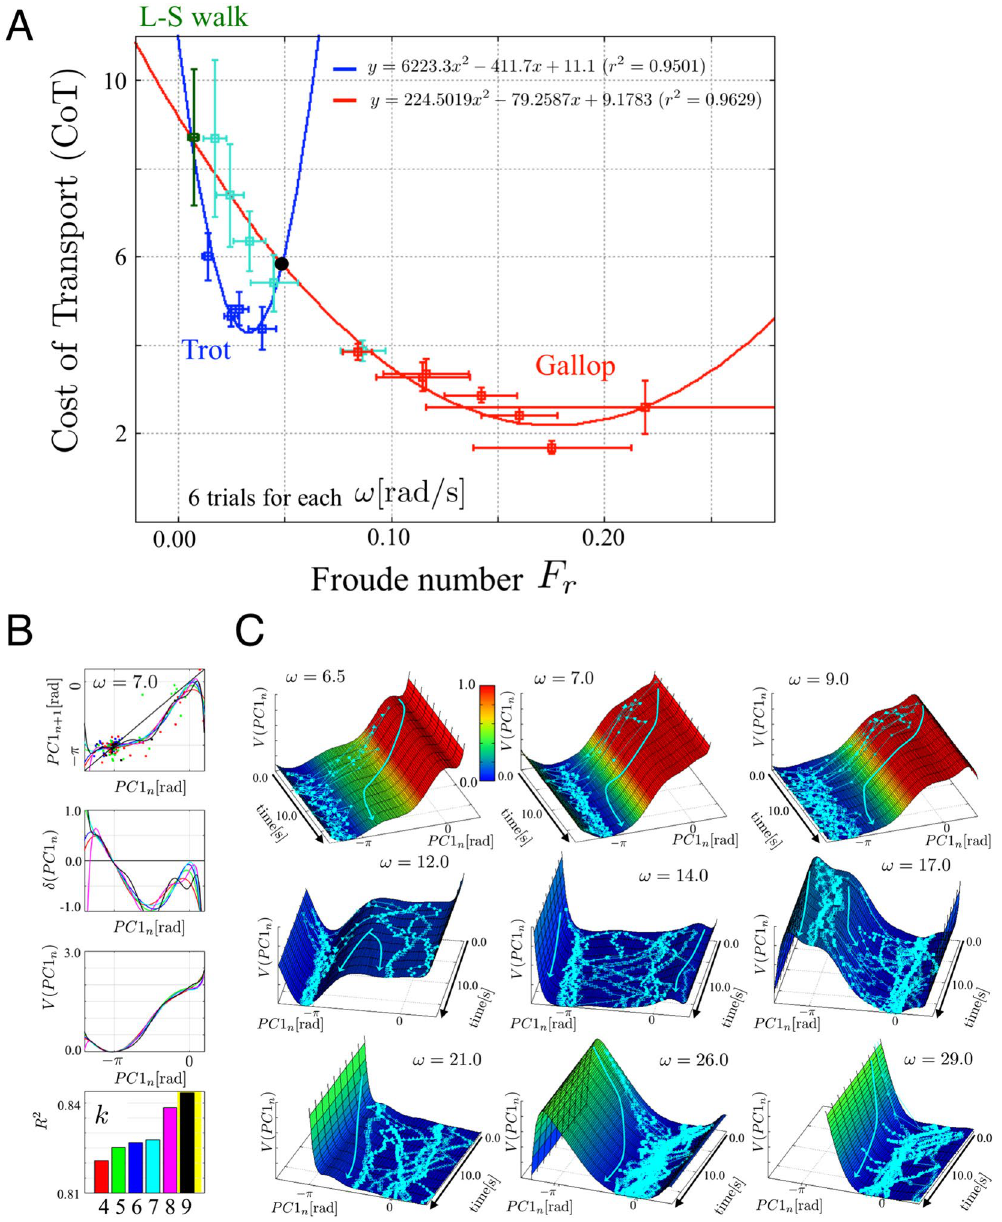
Figure 3. Efficiency and stability. ( A ) Cost of transport (CoT) versus Froude number F r for each value of ω . The colours of data points represent the range of ω values: dark green represents a value less than 6.5, blue represents values ranging from 7.0 to 9.0, cyan represents values between 12.0, and 19.0, and red represents values between 21.0 and 29.0. The blue and red lines represent the best-fitting second-order polynomial curves according to least-squares regression analysis for ω < 10 (blue) and ω > 10 (red). ( B ) The graphs from the top represent return maps PC 1 n + 1 = f ( PC 1 n ), δ PC 1 ( PC 1 n ), potential functions V PC 1 ( PC 1 n ), and R 2 values obtained using polynomial models for approximation for ω = 7.0 rad/s. ( C ) Convergence of PC 1 n (order parameter) on the surfaces of the potential functions, which describes gait stability. Here, we use polynomials ( k = 9). In this figure, the horizontal x , y , and vertical z axes represent PC 1, time t , and the value of the potential function V PC 1 ( PC 1), respectively. The light blue trajectories represent the phase convergence for trials with different initial conditions. The time courses of phase convergence depending on initial conditions were in line with the shapes of potential functions, as shown by arrows in these graphs. In particular, bimodal structures of potential functions at ω = 12.0, 14.0, and 17.0 indicate two possible steady states depending on initial